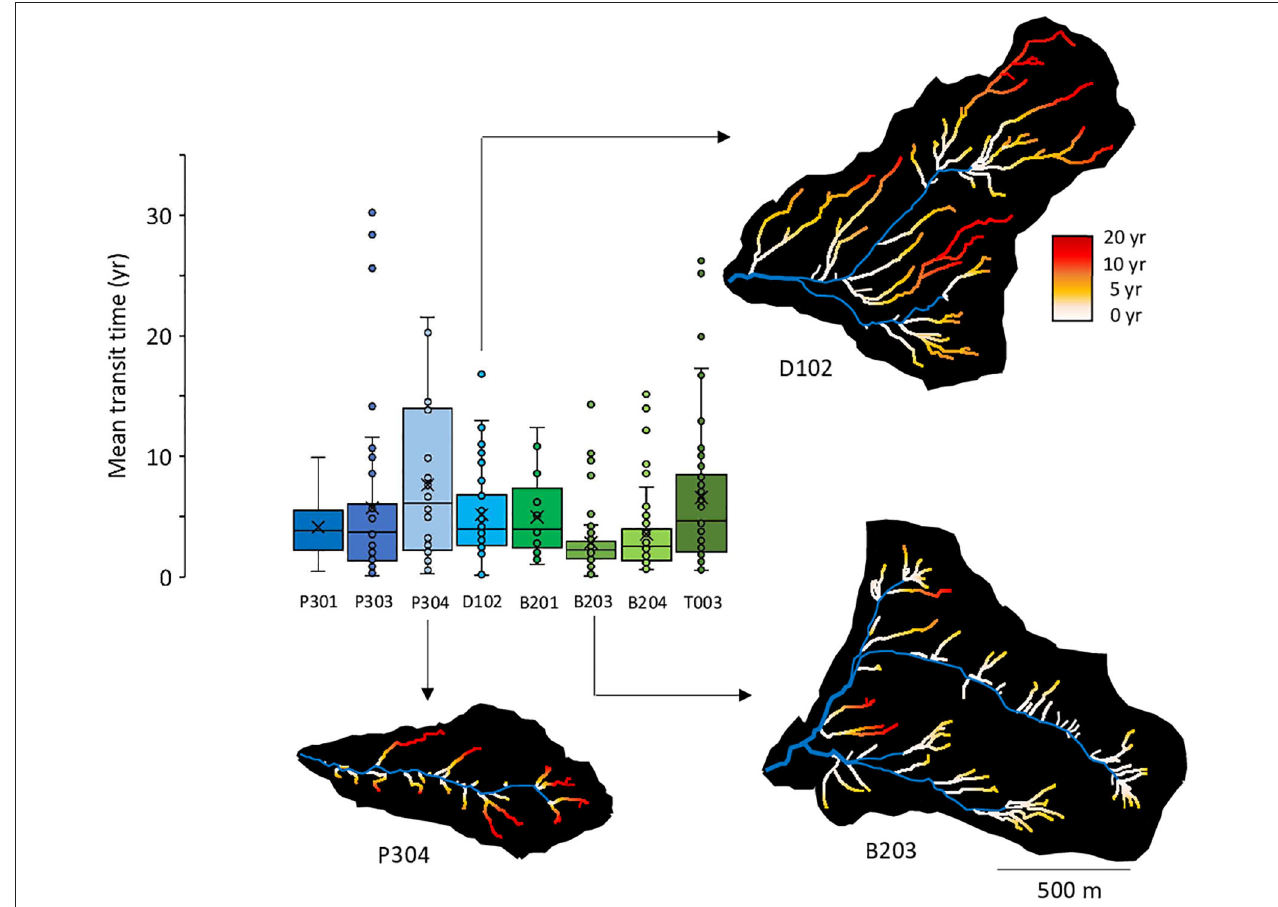
FIGURE 9 | Distribution of the simulated mean transit times along the subsurface flow lines. The distribution is shown for average hydrologic conditions. Mean transit times were calculated by combining subsurface flow line lengths and flow velocities. Illustrations are provided for three watersheds: P304, D102, and B203. The color scale is identical for all the watersheds to highlight the contrast between